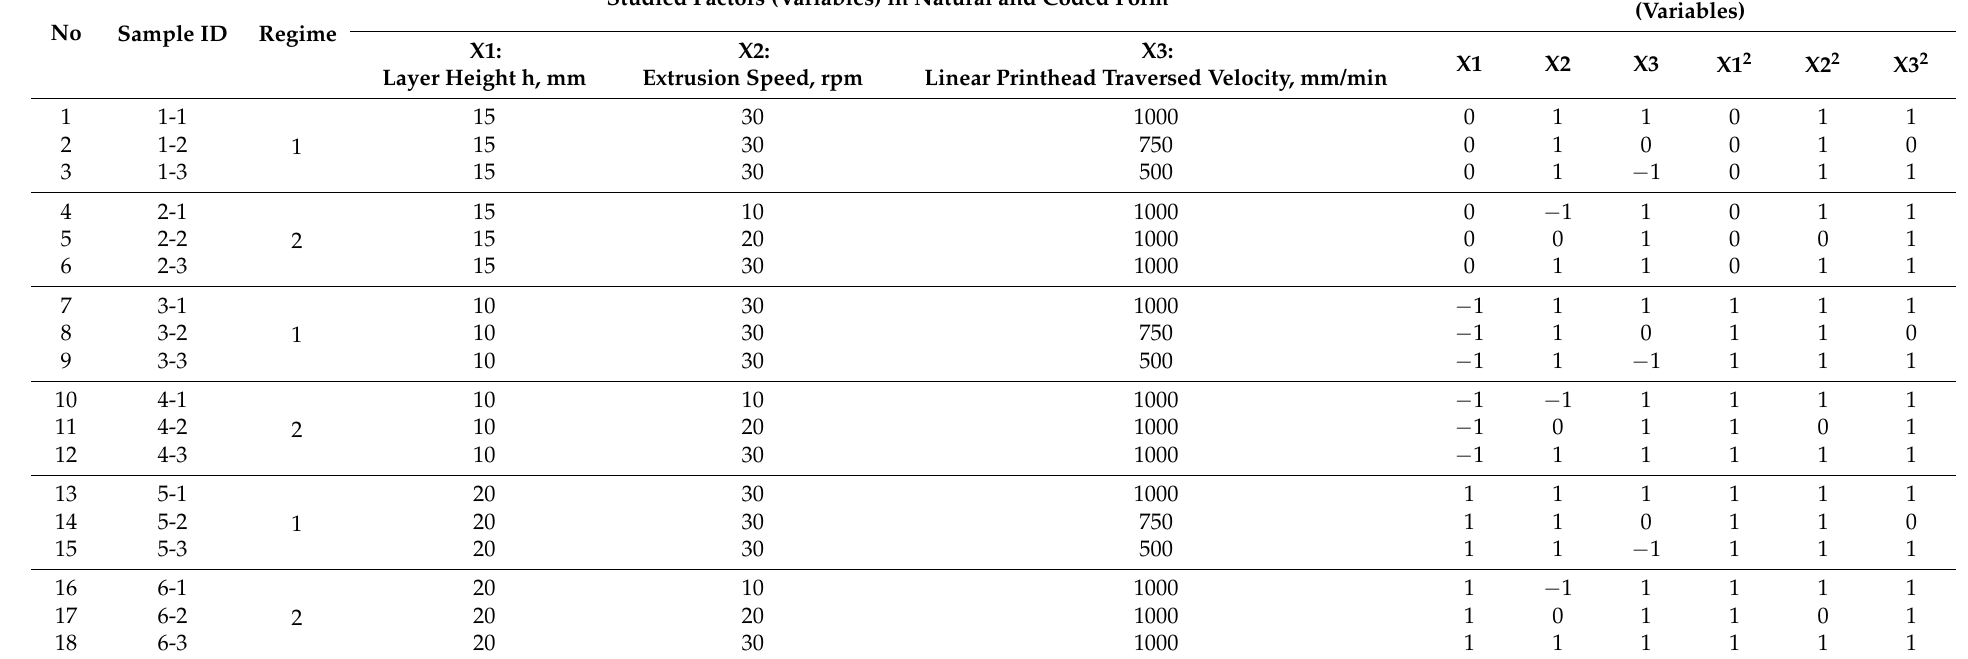
Table 1. Combinations of the studied